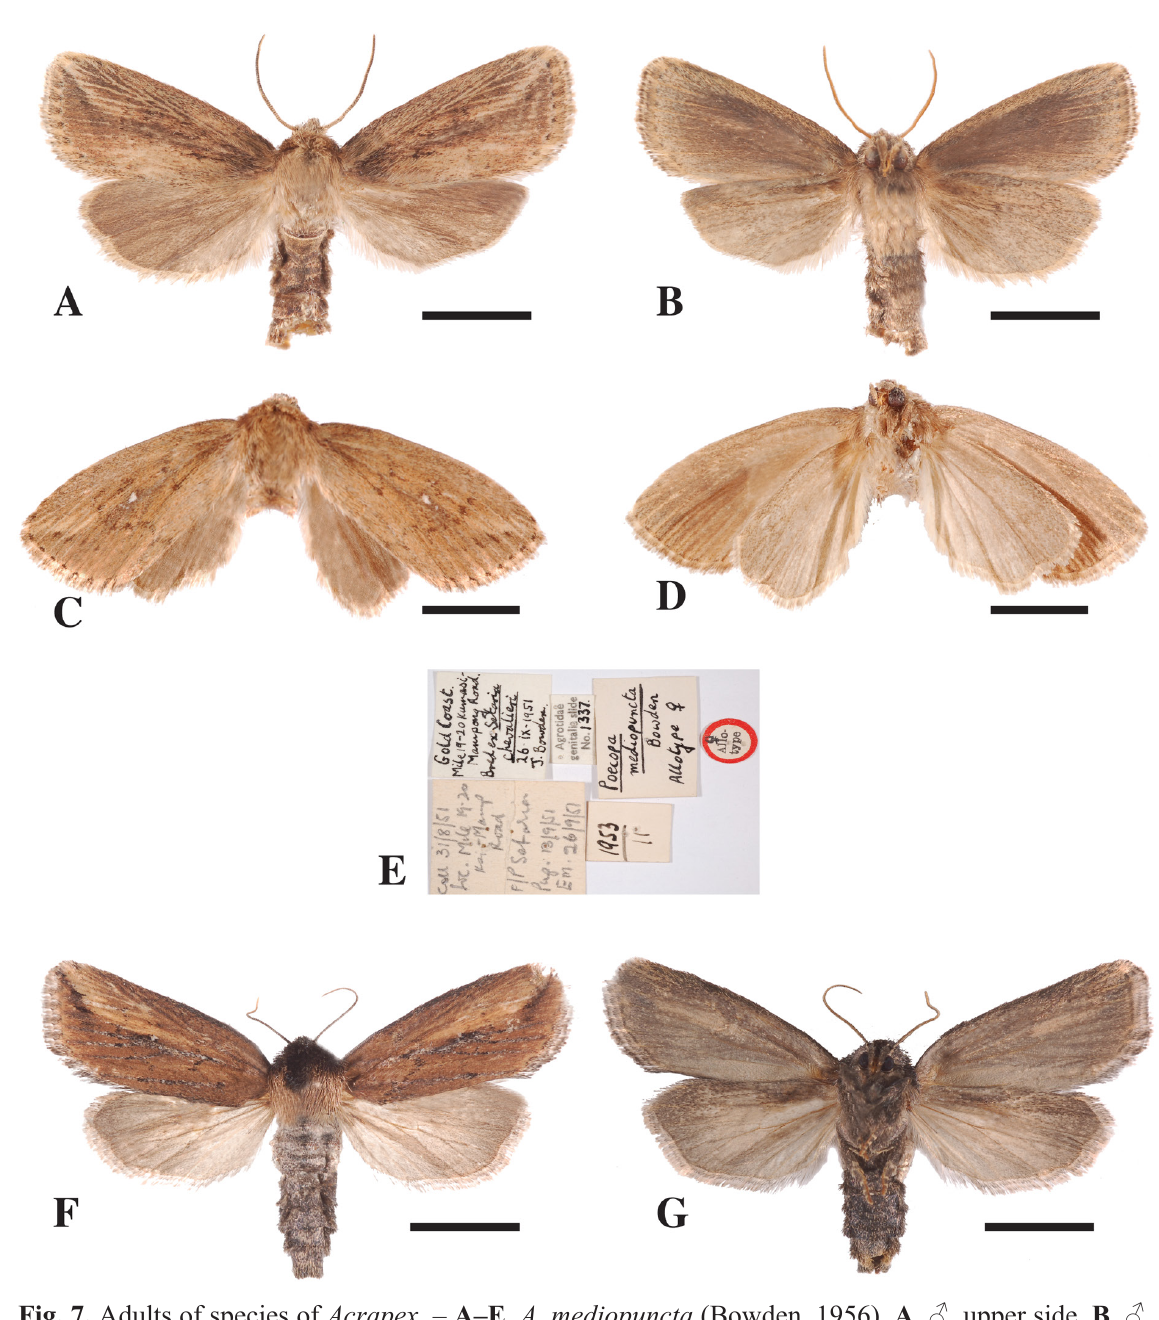
Fig. 7. Adults of species of Acrapex . – A–E . A. mediopuncta (Bowden, 1956). A . ♂, upper side. B . ♂, under side. C . ♀, upper side. D . ♀, under side. E . ♀, original labels from BMNH. – F–G . A. miscantha le Ru sp. nov. F . ♀, upper side. G . ♀, under side. Scale bars = 10